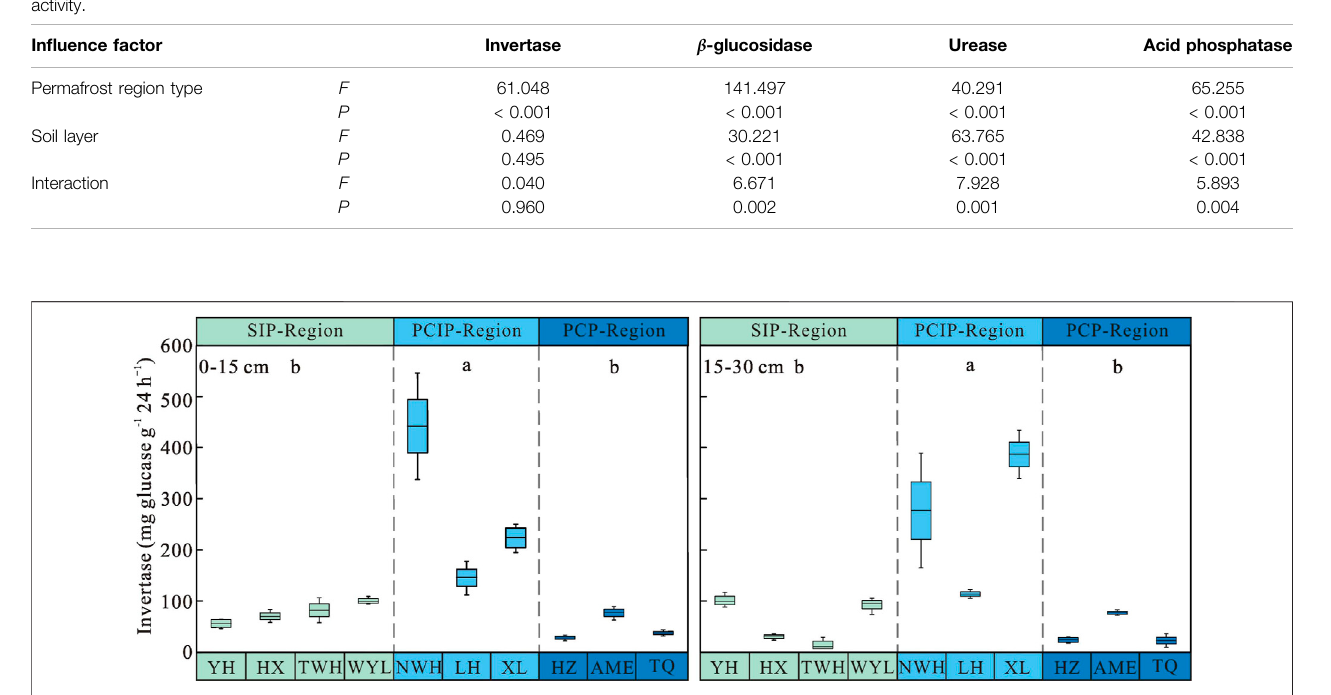
FIGURE 2 | Soil invertase activity in peatlands from different types of permafrost regions. SIP-Region: sparsely island permafrost region; PCIP-Region: predominantly continuous and island permafrost region; PCP-Region: predominantly continuous permafrost region. Different lowercase letters in the fi gure indicate signi fi cant differences in the means between permafrost region types.